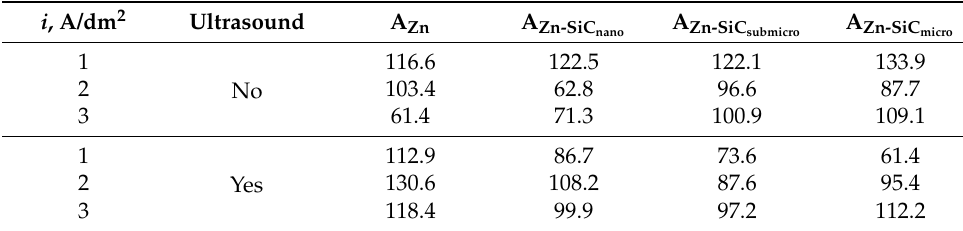
Table 1. A factor values determined based on [ F ( R )* E ]( E ) dependences (Figure 3) for Zn and Zn-SiC coatings deposited from weak acid